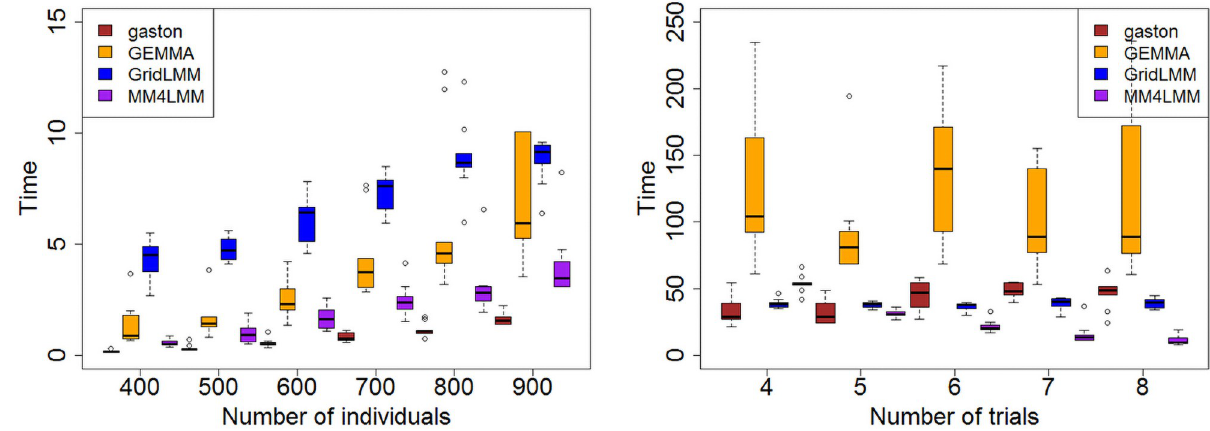
Fig 2. Computational time for variance component analysis with simulated data. Computational time of the algorithms with respect to the number of observations (left) and the number of trials (right).